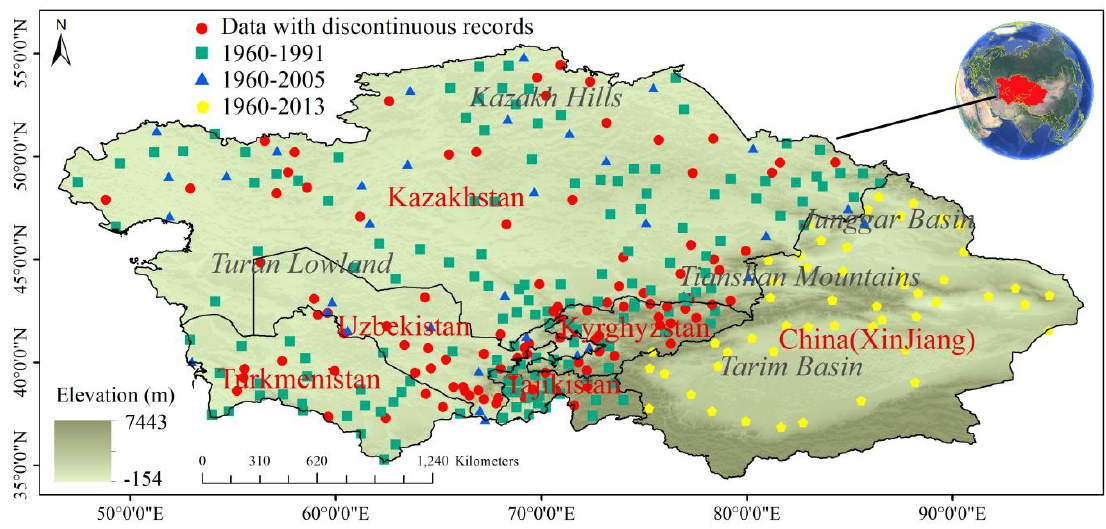
Figure 1. The study area and the geographical distribution of meteorological stations.